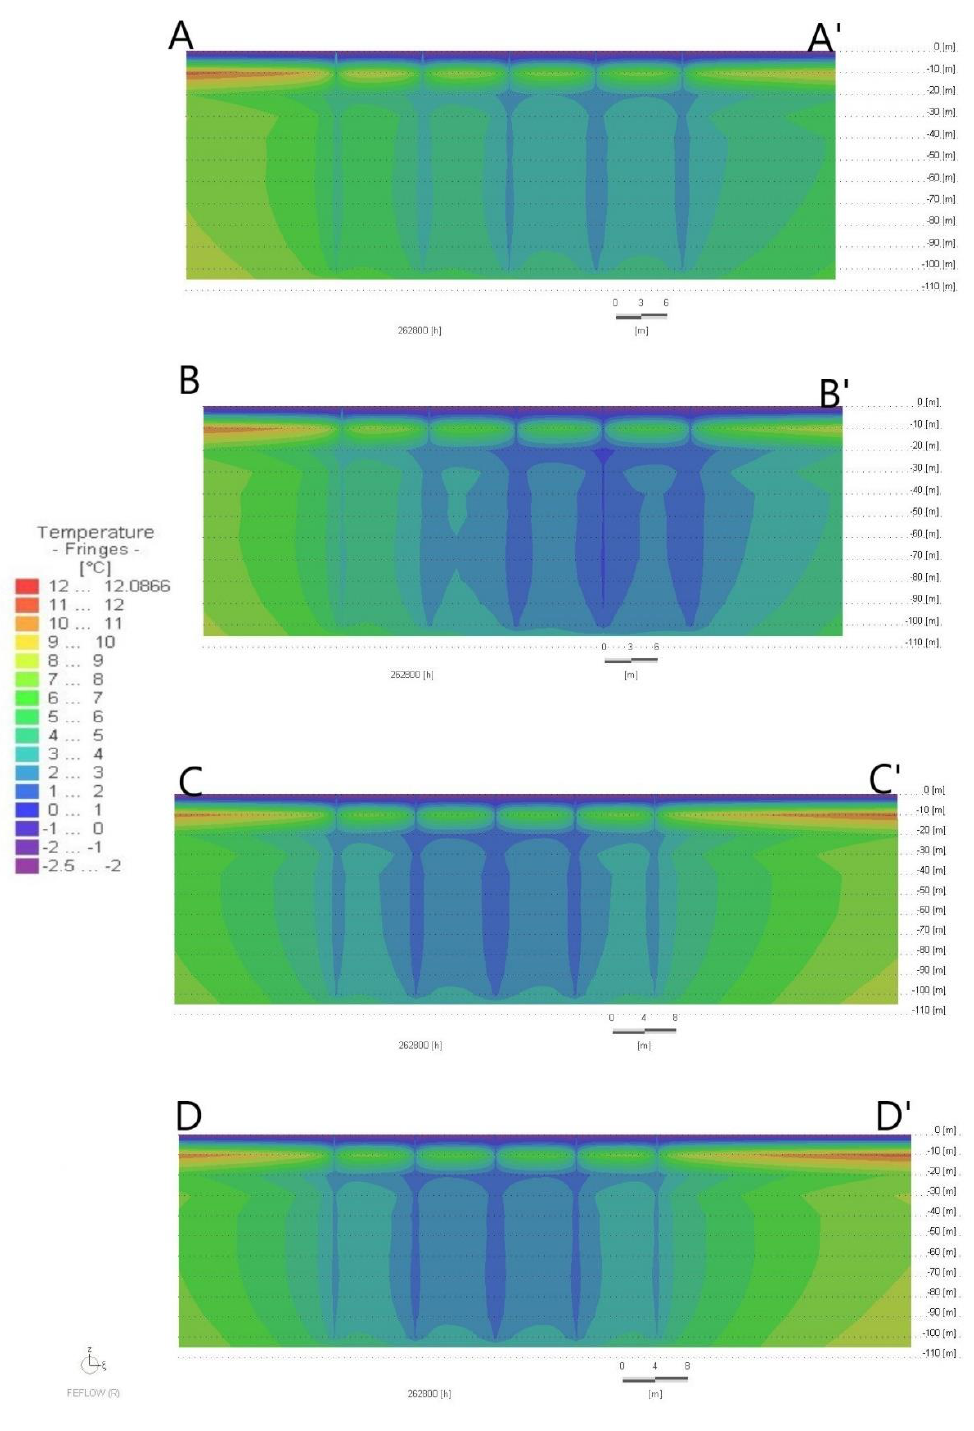
Figure 16. The temperature distribution as a cross-section view for the 3rd scenario. The cross-section lines are the same as those used in Figure